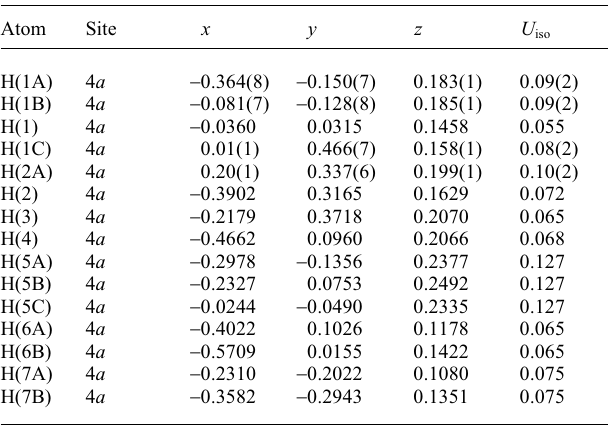
Table 2. Atomic coordinates and displacement parameters (in Å 2 )